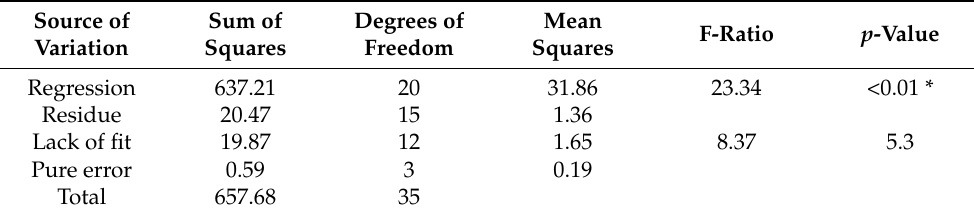
Table 6. The analysis of variance (ANOVA) for C17:1 content (%). * means significant differences ( p < 0.05).